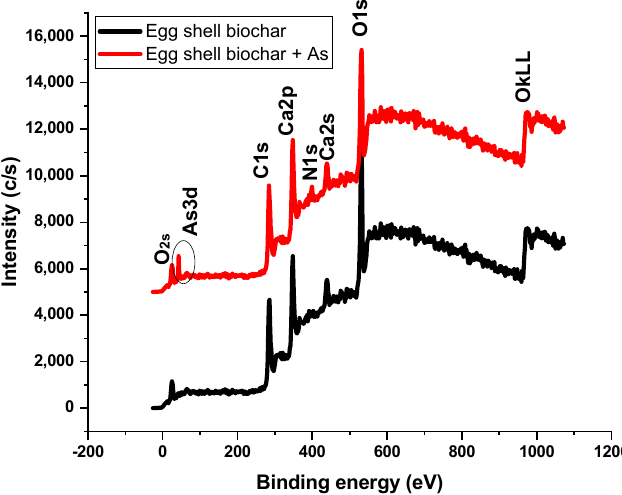
Figure 7. XPS survey scan of As(V) adsorption on egg shell biochar.